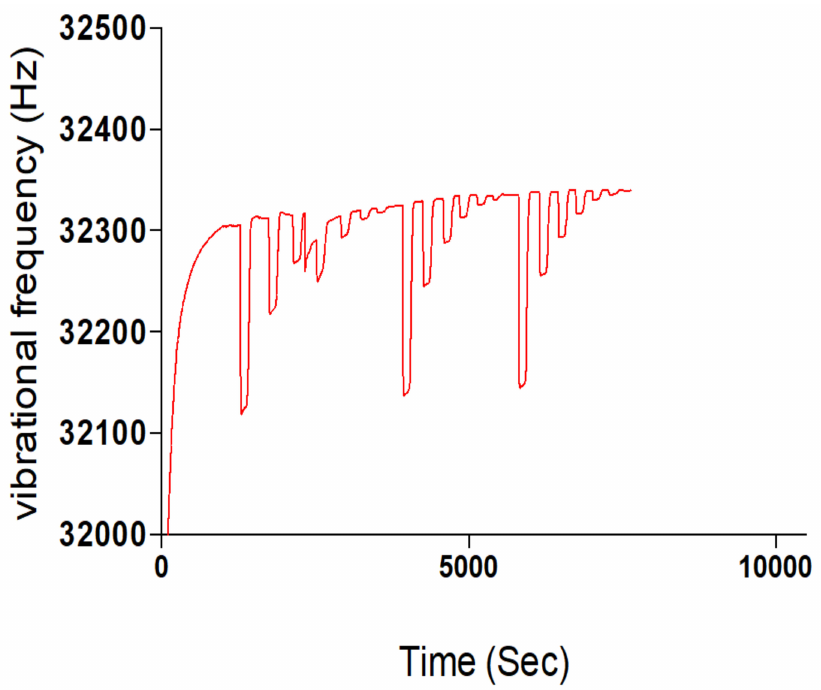
Figure 2. Template rebinding potential of synthesized Chitosan-Nicotine-3-Phenylpiridine MIP.